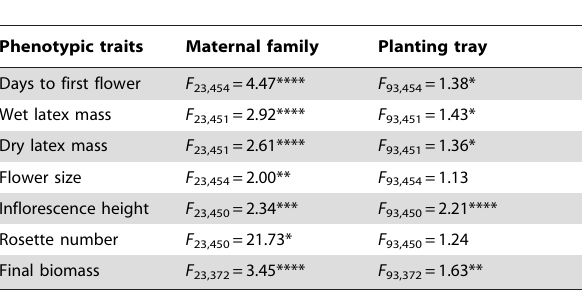
Table 2. Effects of maternal family and planting tray on variation in six phenotypic traits of greenhouse-grown Lobelia siphilitica .